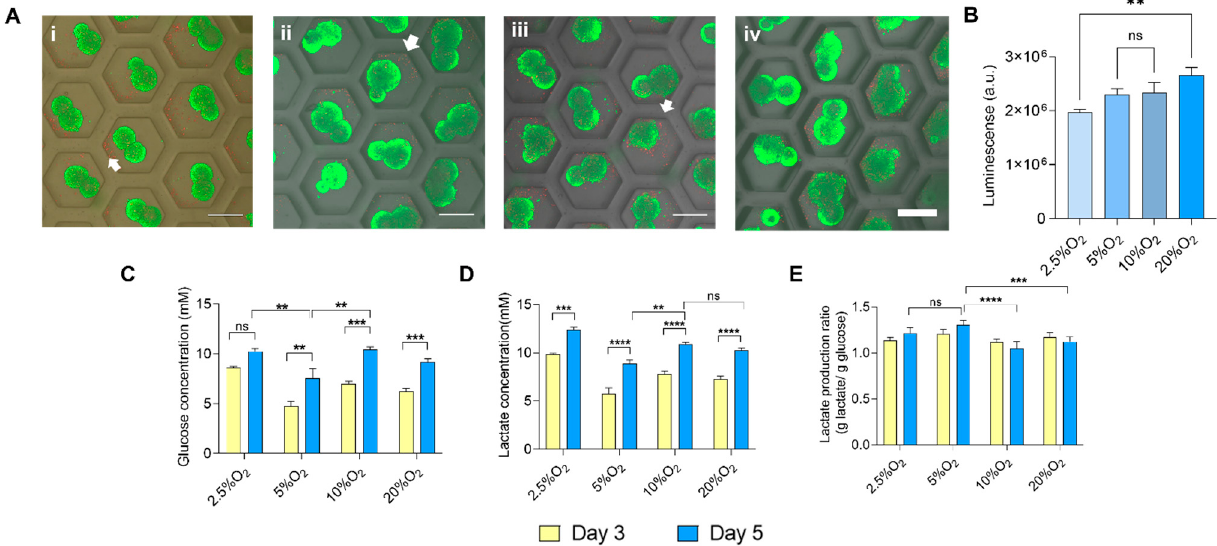
Figure 3. Cell viability and metabolism of the hiPSC aggregates. ( A ) Live dead staining of aggregates grown in ( i ) 2.5%, ( ii ) 5%, ( iii ) 10%, and ( iv ) 20% O 2 , scale bar: 200 µm. ( B ) Quantitative analysis of cell viability using CellTiter Glo ® assay at Day 5. ( C ) Glucose consumption of the aggregates at Days 3 and 5. ( D ) Lactate was secreted in the culture supernatant at Days 3 and 5. ( E ) Lactate production ratio depicting lactate secretion to that of glucose consumption at Days 3 and 5. Statistical analysis was performed with one-way ANOVA/Tukey’s test. ** p < 0.01, *** p < 0.001, **** p < 0.0001; ns = non-significant with N = 3 sets of independent experiments.